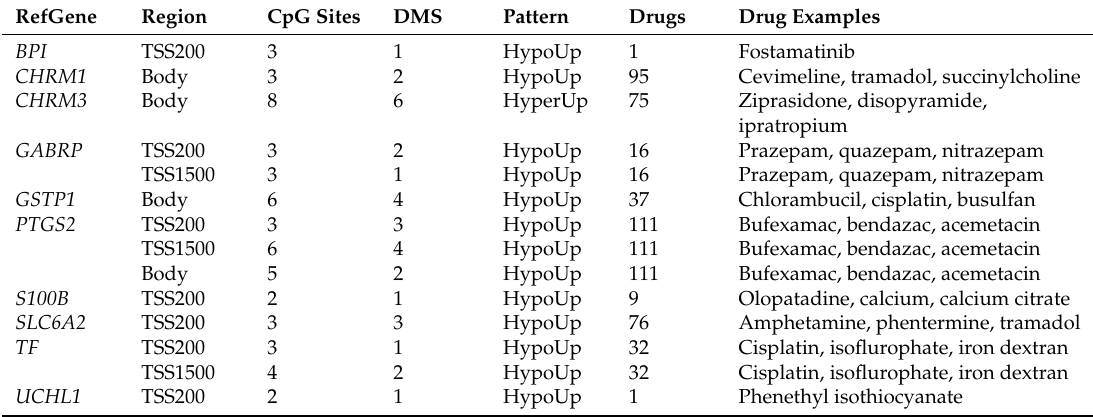
Table 3. Ten genes targeted by specific drugs. DMS—di ff erentially methylated CpG site. RefGene